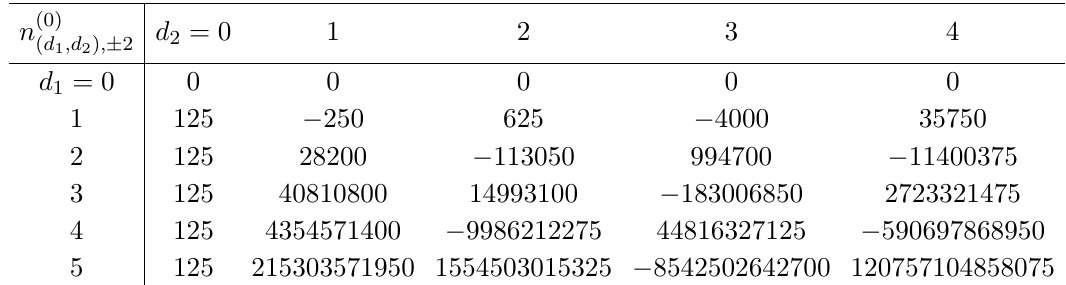
Table 36 . Genus 0 Gopakumar-Vafa invariants for X (5)